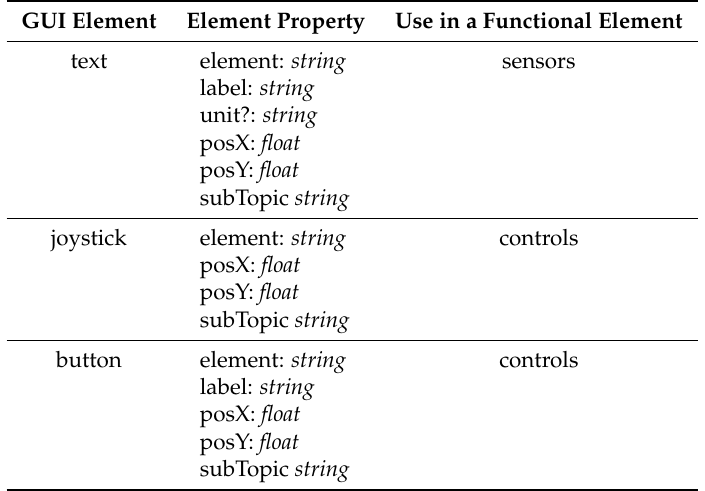
Table 1. Overview of elements and their data types in the definition scheme. GUI Element Element Property Use in a Functional